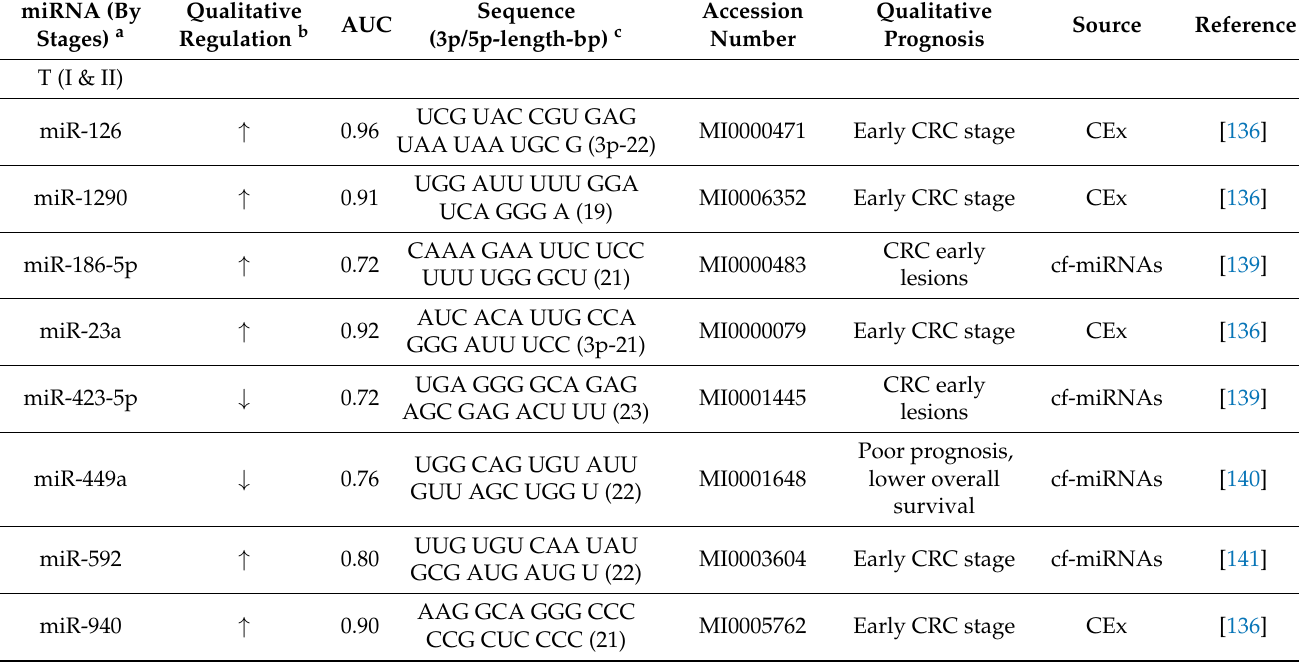
Table 3. Summary of promising reported miRNA from patient blood samples for potential CRC diagnosis and prognosis since